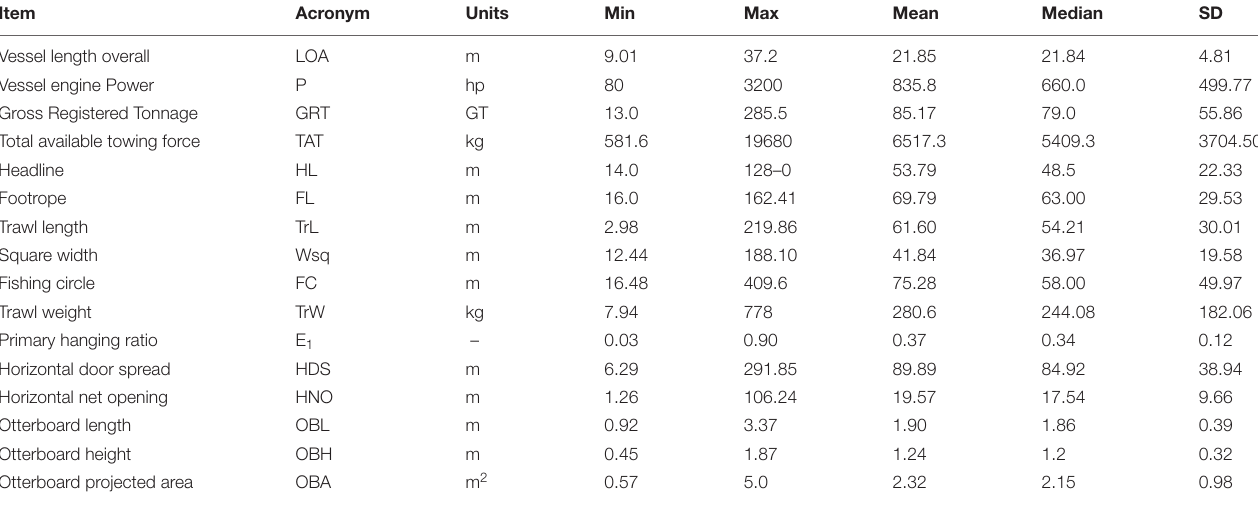
TABLE 2 | Summary table of the descriptive statistics of gear, vessel and otterboard’s metrics observed.